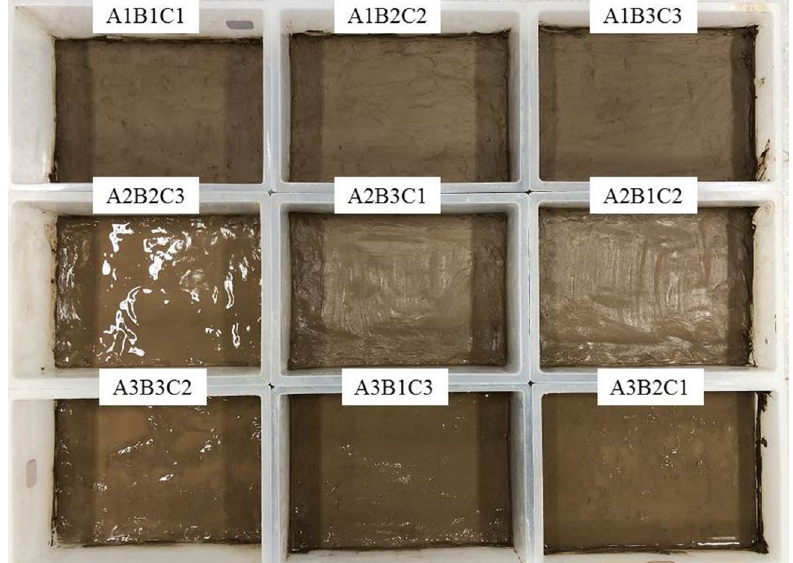
Figure 3. Samples and moulds.